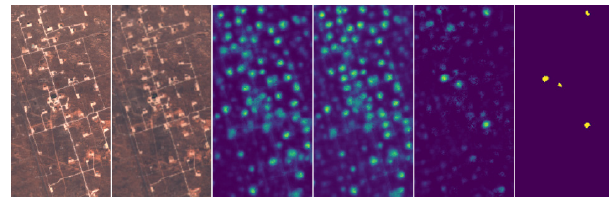
Figure C3. Left to right: before (1) and after (2) medium-resolution imagery (ESA, 2020); same area in model output: (3) before, (4) af- ter, (5) difference, and (6) detected new well pads.